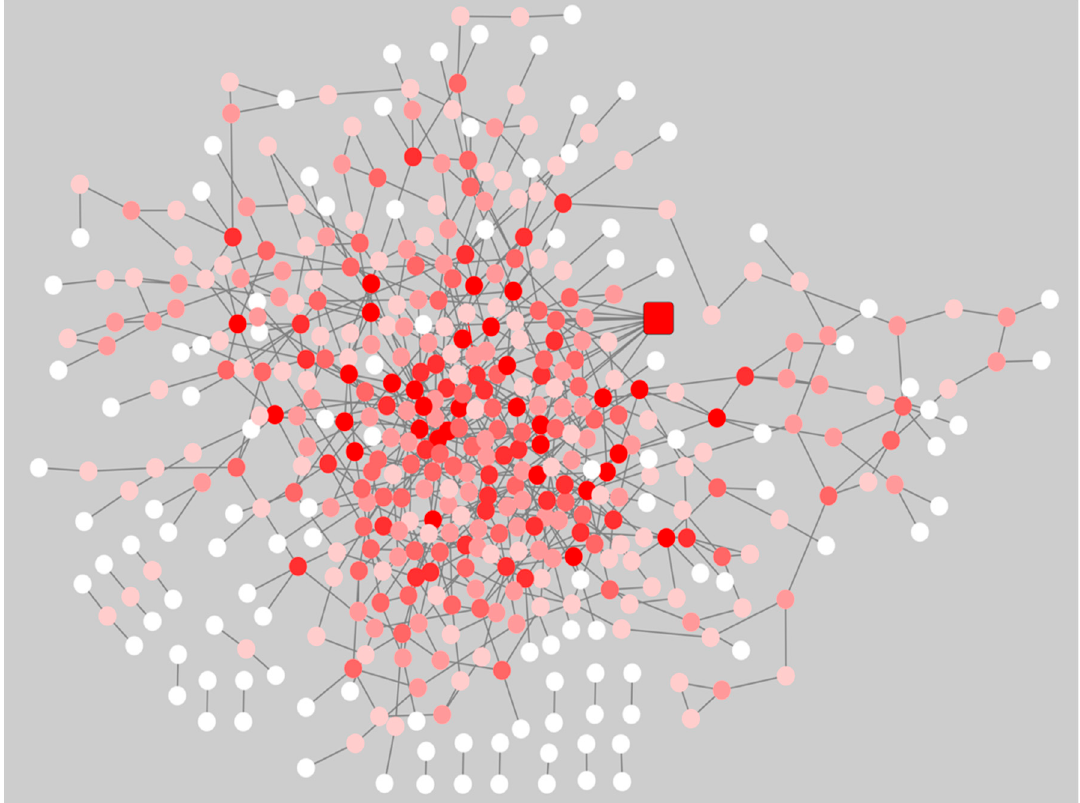
Figure 2. Central reference network of the pre-symptomatic and symptomatic HD network using the Cytoscape plug-in DyNet. Dark red nodes: Most highly re-wired nodes, Medium red: Highly re-wired nodes, Light red: Least most re-wired nodes and White nodes: No re-wiring. The square node indicates the CACNA1I gene, which was the most highly re-wired node based on the DyNet re-wiring